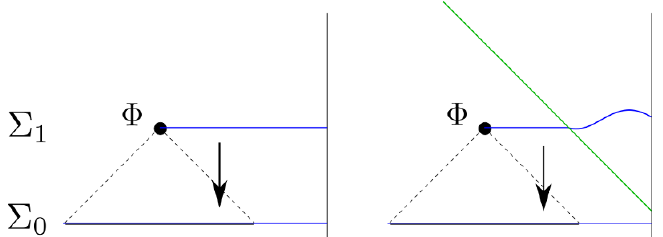
Figure 2 . Depiction of our de(cid:12)nition of \same point," ( X t ; t ) (cid:24) ( X H ; t ). Note that the dress- B ings reach the same point in the old geometry as de(cid:12)ned by their destance to the original black hole horizon or RT surface. By backwards evolving using the respective Hamiltonians should give equivalent expressions for the operators as described in equation